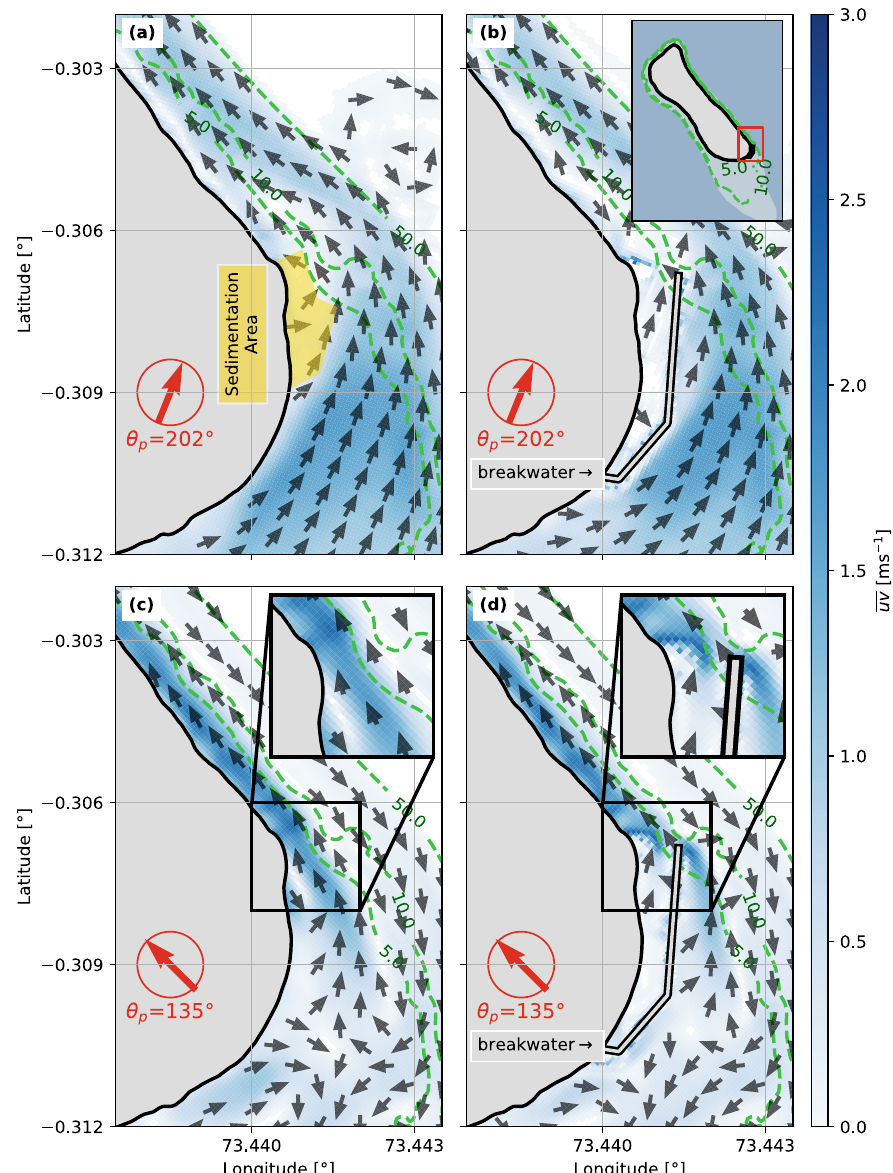
Fig. 7 Wave-induced currents and impact of the seaport on the natural hydro- and morphodynamics. Wave-induced currents uv from the depth- integrated (2DH) model for the seaport area in the southeast of Fuvahmulah, where the colorbar shows the magnitude of the current between 0.0 ms − 1 (white) to 3.0 ms − 1 (blue), while arrows depict the current direction. a shows velocity fi elds from waves with a peak direction of θ p = 202 ∘ for Fuvahmulah without the harbor, while b includes seaport infrastructure. Similarly, c shows wave-induced currents before the port construction, while d presents today ’ s situation with the harbor present for waves approaching from θ p = 135 ∘ . Green dashed contours show the water depths of the reef platform for 5 m, 10 m, and 50 m. Maps are based on measurements and adapted publicly available © OpenStreetMap contributors data, accessed through the open-access Geofabrik download